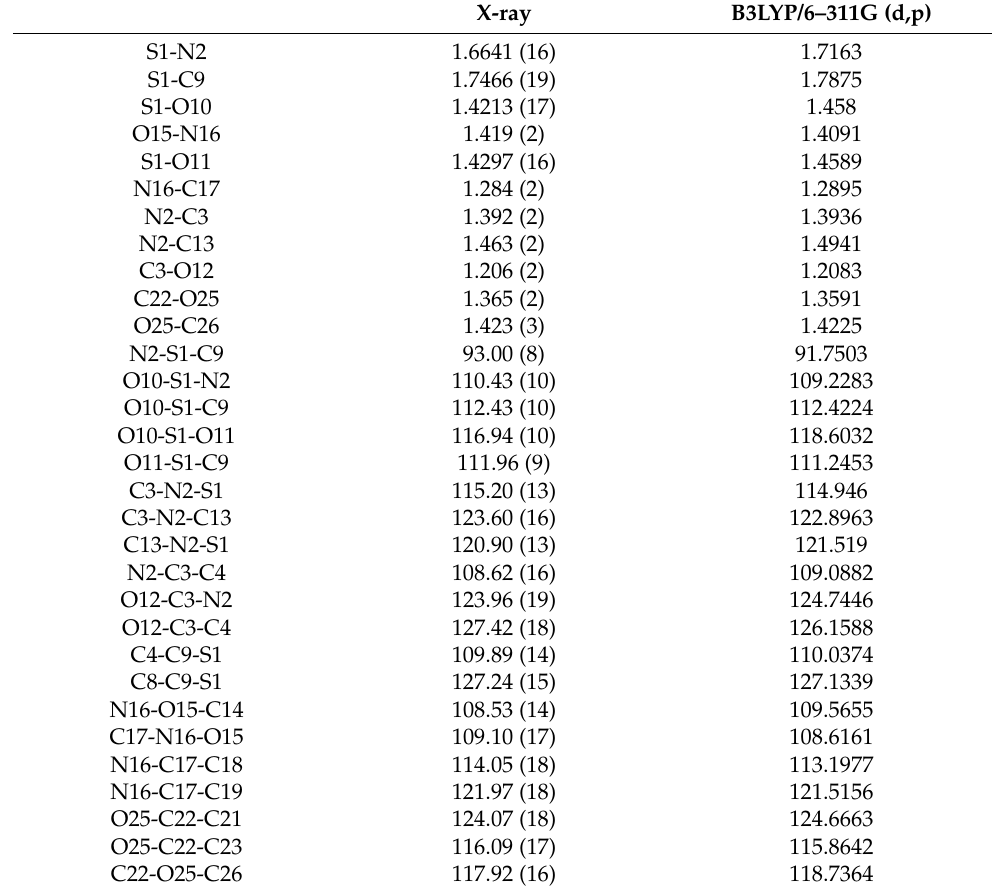
Table 1. Comparison (X-ray and density functional theory) of selected bond lengths and angles (Å, ◦ ).